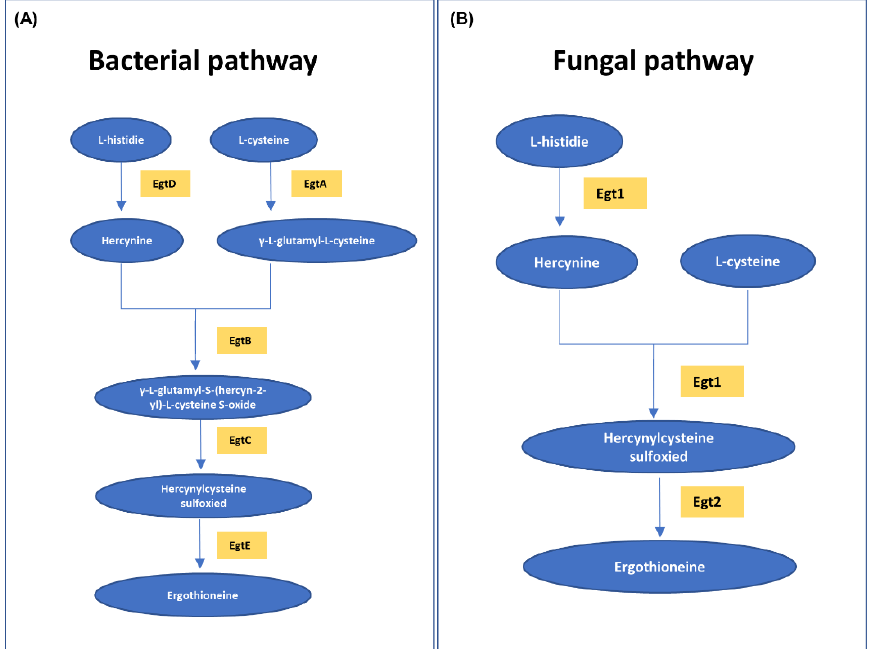
Figure 5. Ergothioneine biosynthesis. ( A ) Ergothioneine biosynthesis in bacteria and ( B ) ergothioneine biosynthesis in fungi via the MetaCyc pathway. The pathways are represented by the substances (blue circles) and enzymes (yellow squares) involved.